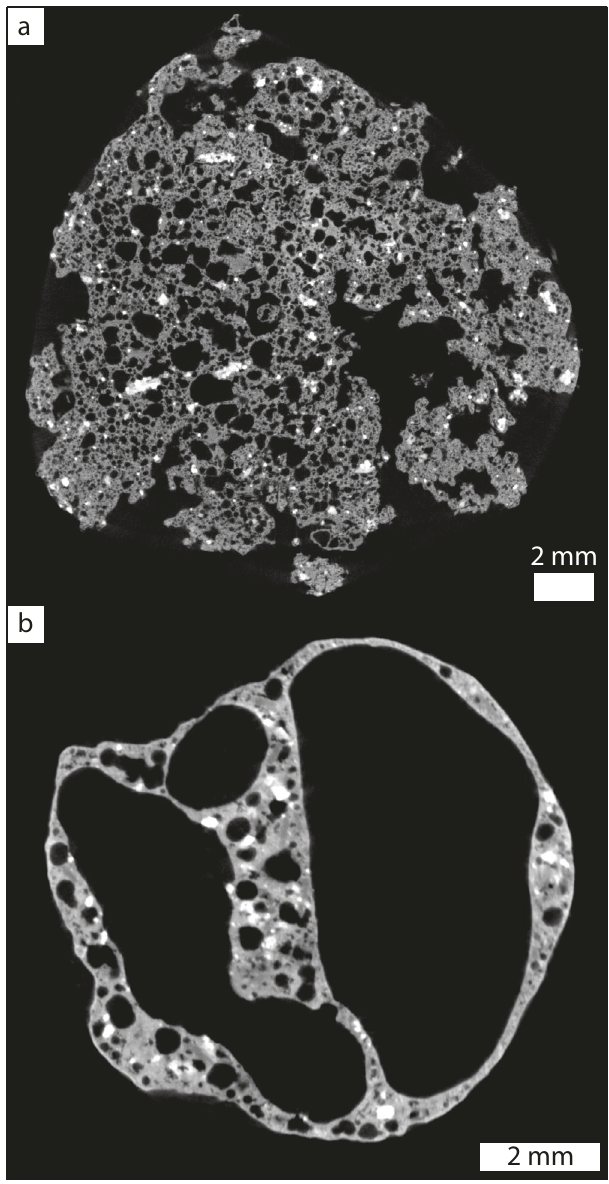
Fig. 6 X-ray computed tomography derived images. a Image slice through regular scoria found adjacent to the in fl ated pyroclasts within the same deposit. This scoria clast has a bulk vesicularity of 76.5%. b Image slice through an in fl ated pyroclast. This in fl ated pyroclast has a bulk vesicularity of 89.7%. Note the difference in scale bar length between the two